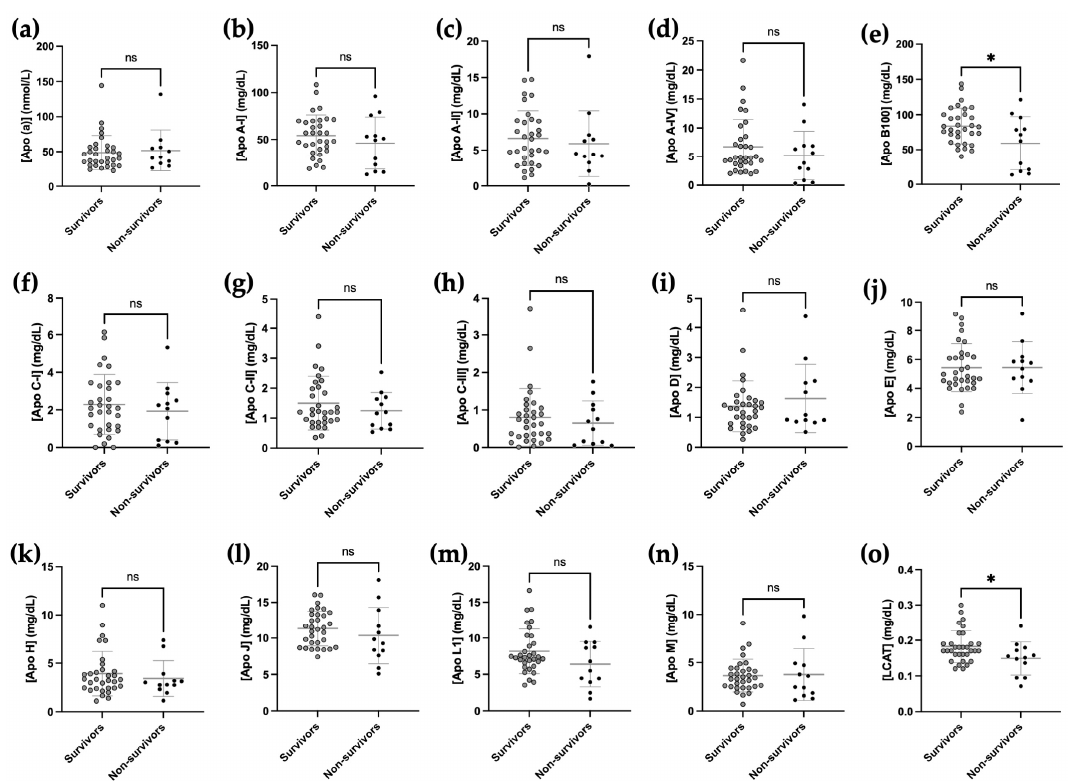
Figure 6. Decreased apolipoprotein B100 and LCAT concentration in plasma of non-survivors COVID-19. Fourteen apolipoproteins ( a – n ) and LCAT ( o ) were measured by mass spectrometry in the plasma